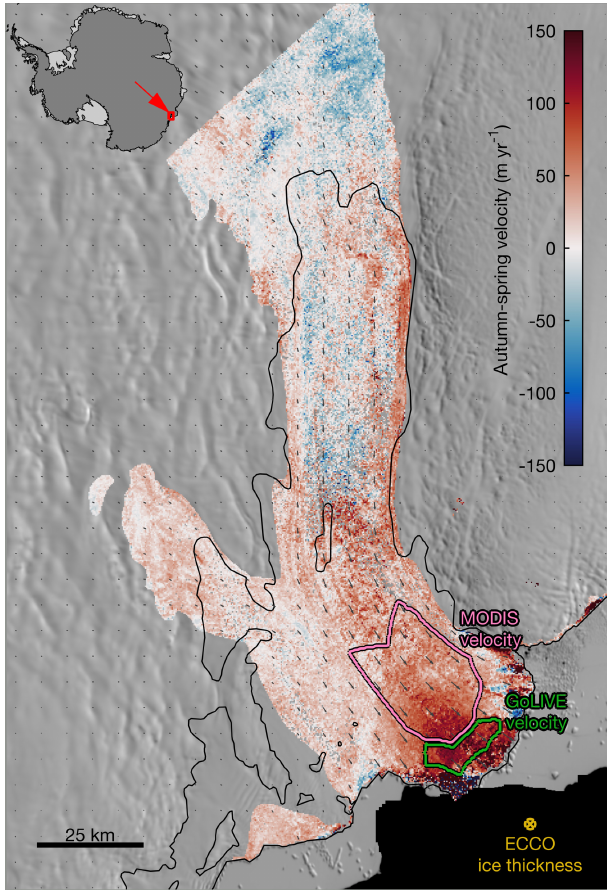
Figure 1. Summer ice shelf acceleration. Toward the calving front (right bottom of the image), autumn velocity exceeds spring ve- locity by more than 100myr − 1 . This image shows the difference between the means of 76 spring and 67 autumn GoLIVE velocity fields. Dark green vectors indicate the mean velocity, supplemented by MEaSUREs-InSAR-derived velocity (Rignot et al., 2011) out- side the range of Landsat path 102, row 107. Green and pink poly- gons indicate the bounds of velocity averaging for the velocity time series shown in Figs. 2 and 3. A gold marker shows the location of the ECCO sea ice thickness time series described in Sect. 5. The calving front and grounding line are shown in black, including a grounded ice rumple near the center of the ice shelf (Mouginot et al., 2017b).